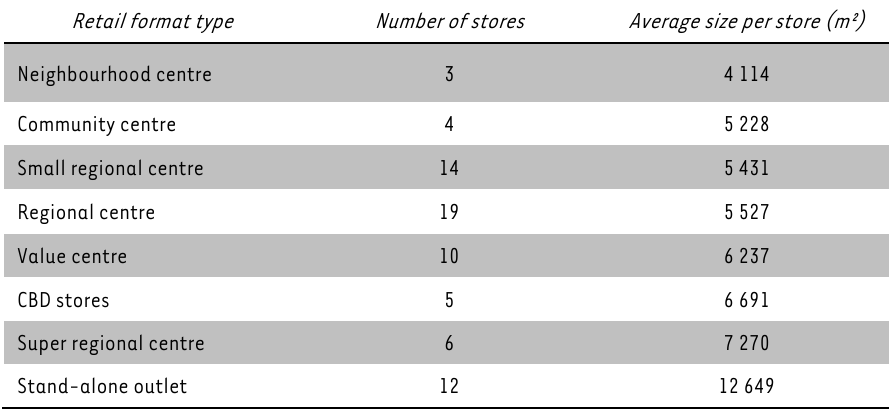
TABLE 1: Number and average sizes of stores by format type Retail format type